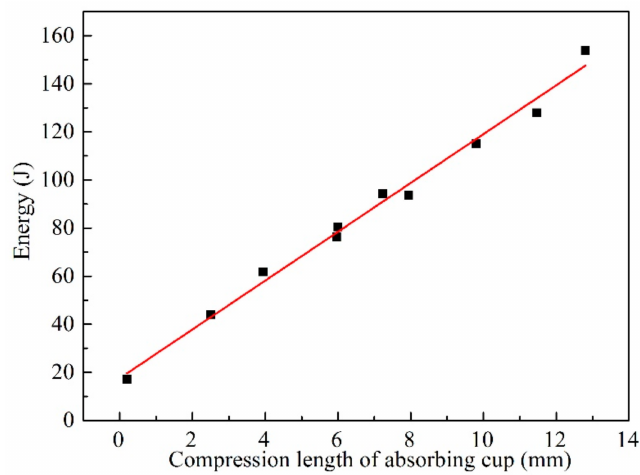
Figure 15. The fitted energy–length curve.